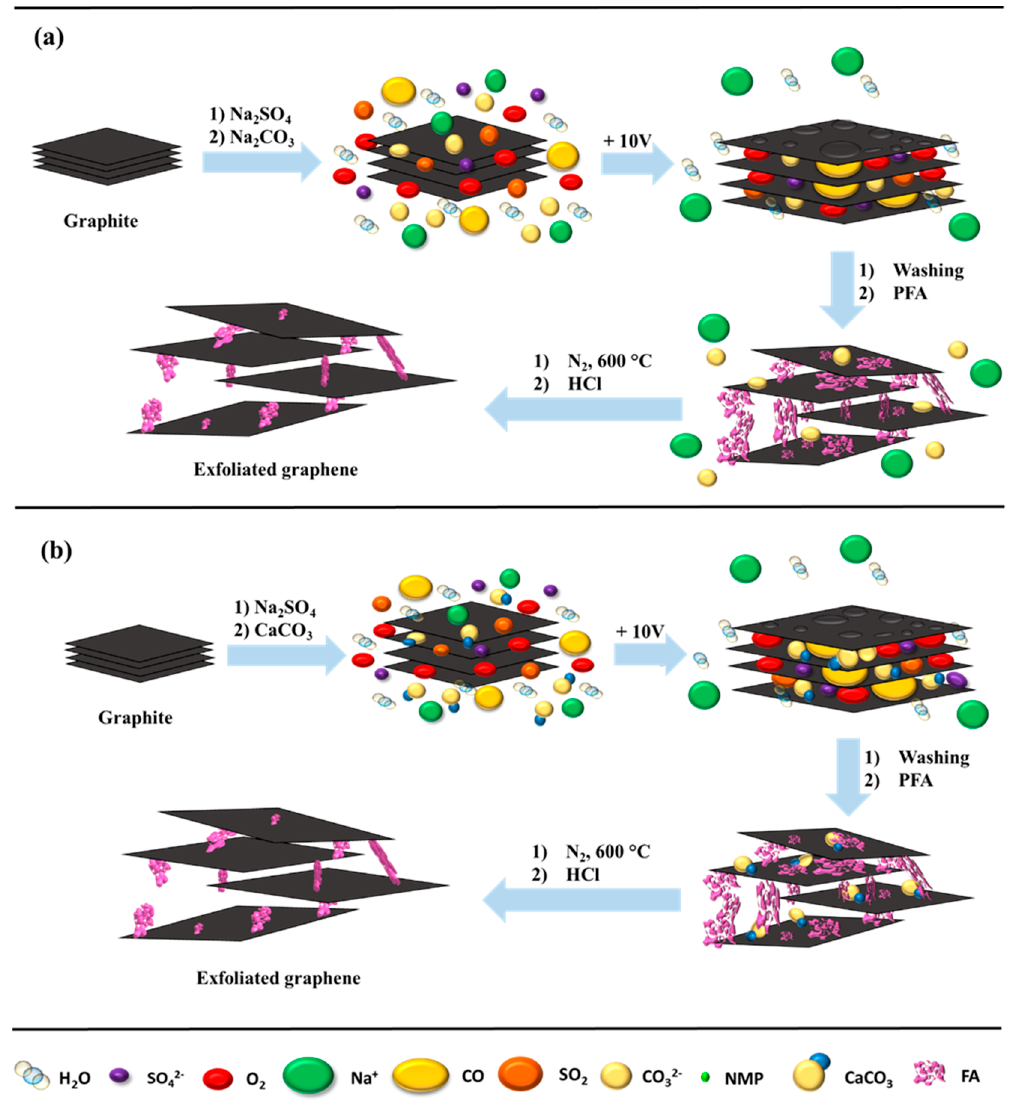
Figure 2. Schematic illustration of the mechanism of electrochemical cathodic exfoliation with: (a) Na 2 CO 3 and (b) CaCO 3 as a separator and poly(furfuryl alcohol) (PFA) as a stabilizer. Table 1. Raman peak positions and intensities for the products obtained from samples in di ff erent series. D peak G peak 2D peak Sample I D / I G I 2D / I G (cm − 1 ) (cm − 1